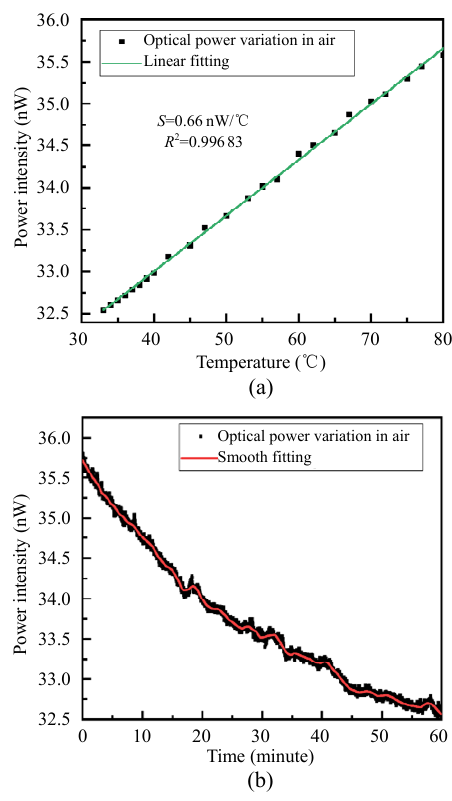
Fig. 5 Optical power variation of ZnO-nanograting sensor (a) with temperature change in the air and (b) over time